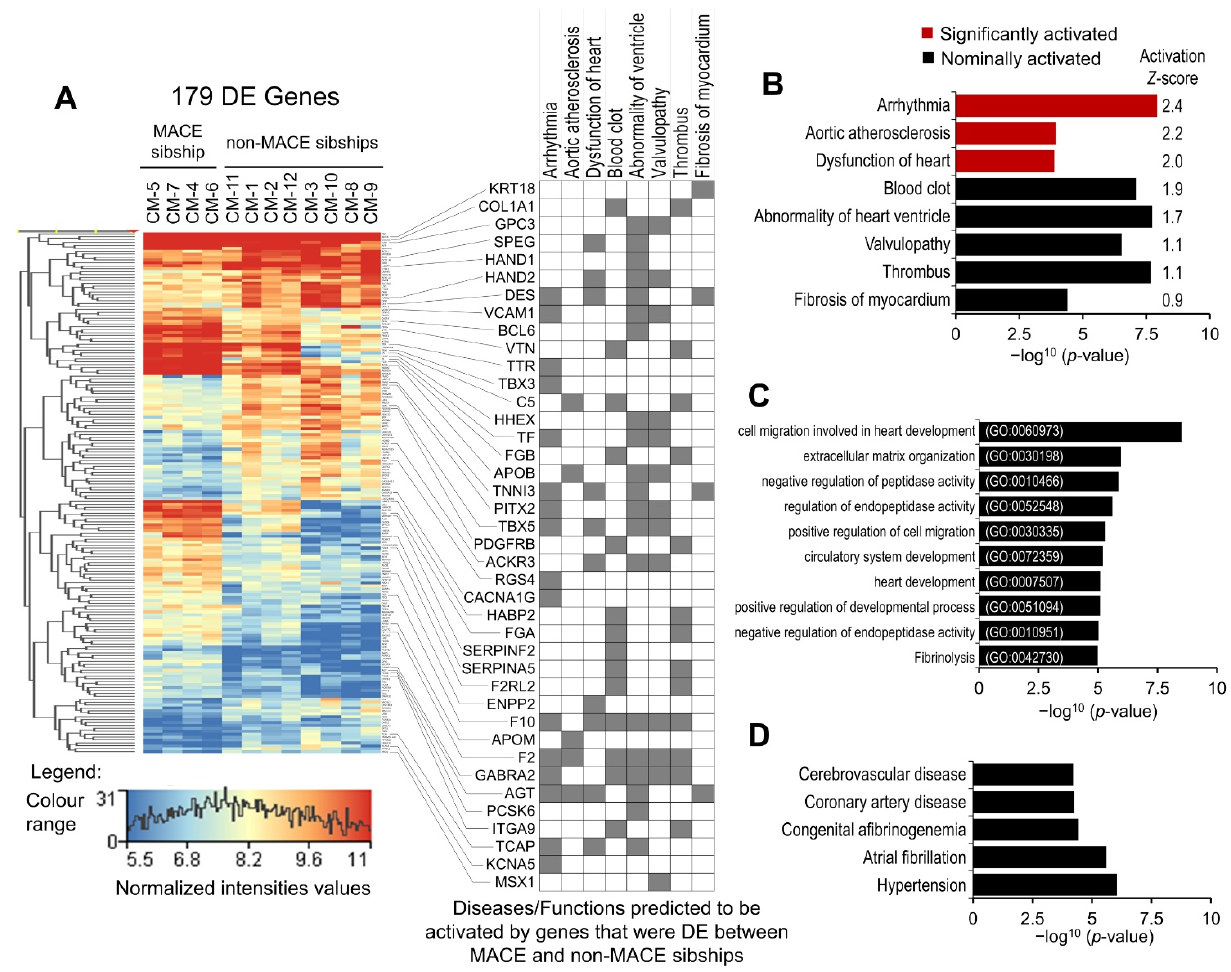
Figure 4. Differential gene expression analysis of CMs-upregulated transcriptome between MACE-affected ( n = 4) and unaffected sibships ( n = 8). ( A ) Heat map of 179 DE genes and disease annotation grid showing enrichment of DE genes in diseases that were predicted to be activated in IPA analysis. ( B ) Enrichment p -values and activation z -score of three significantly activated and five nominally activated diseases, predicted in IPA disease enrichment analysis. ( C ) Top 10 significantly enriched GO biological processes in MACE-associated DE genes. ( D ) Top 5 significantly enriched disease conditions identified in Jensen diseases data base enrichment analysis of MACE-associated DE genes.